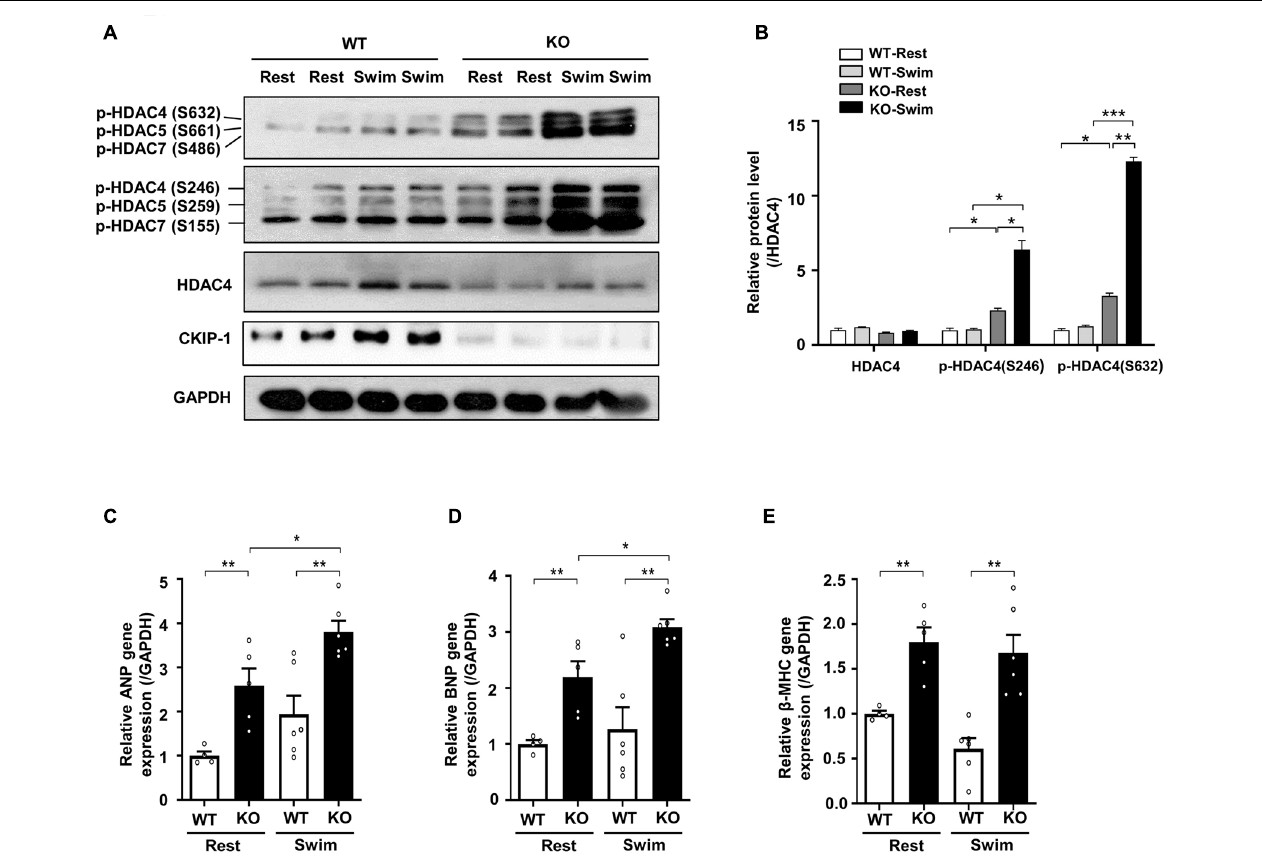
FIGURE 4 | CKIP-1 deficiency exacerbates HDAC4 phosphorylation during exercise induced physiological cardiac hypertrophy. CKIP-1, phosphorylated-HDAC4 (S632), phosphorylated-HDAC4 (S246), and HDAC4 protein expression were measured by Western blot (A) and quantification of p-HDAC4 (S632), p-HDAC4 (S246), and HDAC4 levels in WT and CKIP-1 KO mice in response to swimming exercise (B) . (C–E) Quantitative polymerase chain reaction analyses of the mRNA levels of hypertrophic marker genes (ANP, BNP, and β -MHC) in the indicated groups. Values are means ± SEM, n = 4 ∼ 6, ∗ P < 0.05, ∗∗ P < 0.01, ∗∗∗ P < 0.001. Statistical differences among groups were analyzed by two-way analysis of variance (ANOVA) followed by the Bonferroni procedure. CKIP-1, casein kinase-2 interacting protein-1; WT, wild type; KO, knockout; HDAC4, histone deacetylase 4; ANP, atrial natriuretic peptide; BNP, brain natriuretic peptide; β -MHC, myosin heavy chain β